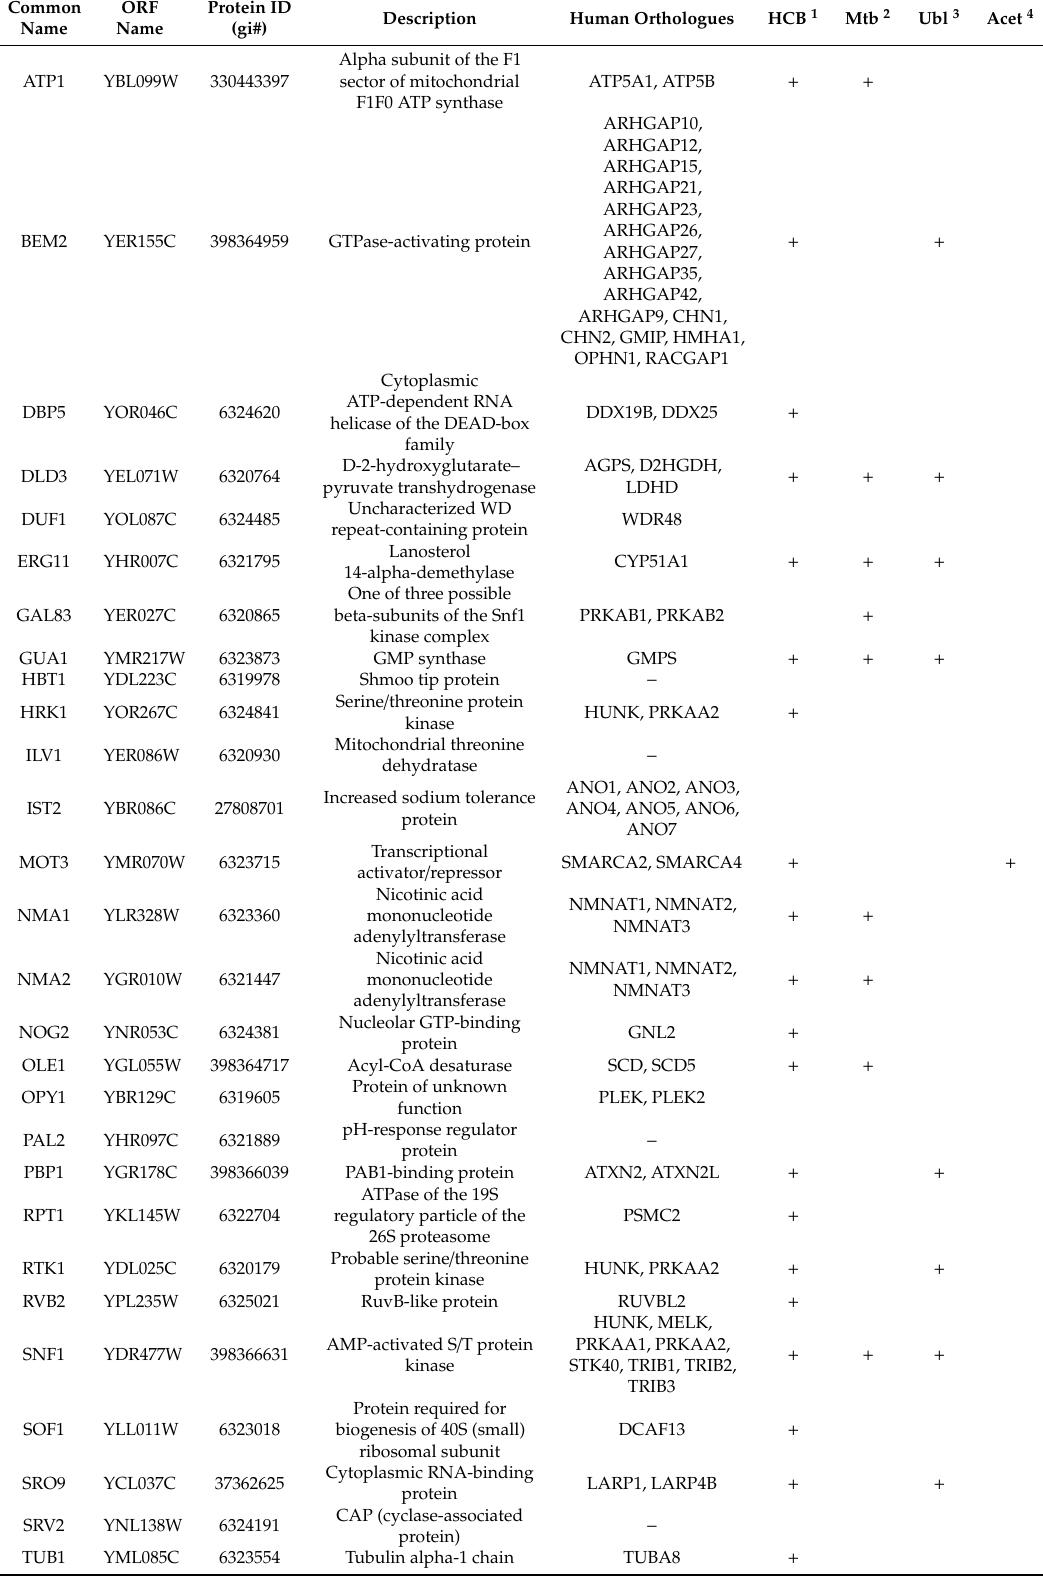
Table3. Listofboundproteinsfoundinextractsfrombothhypoxicandnormoxicorheme-su ffi